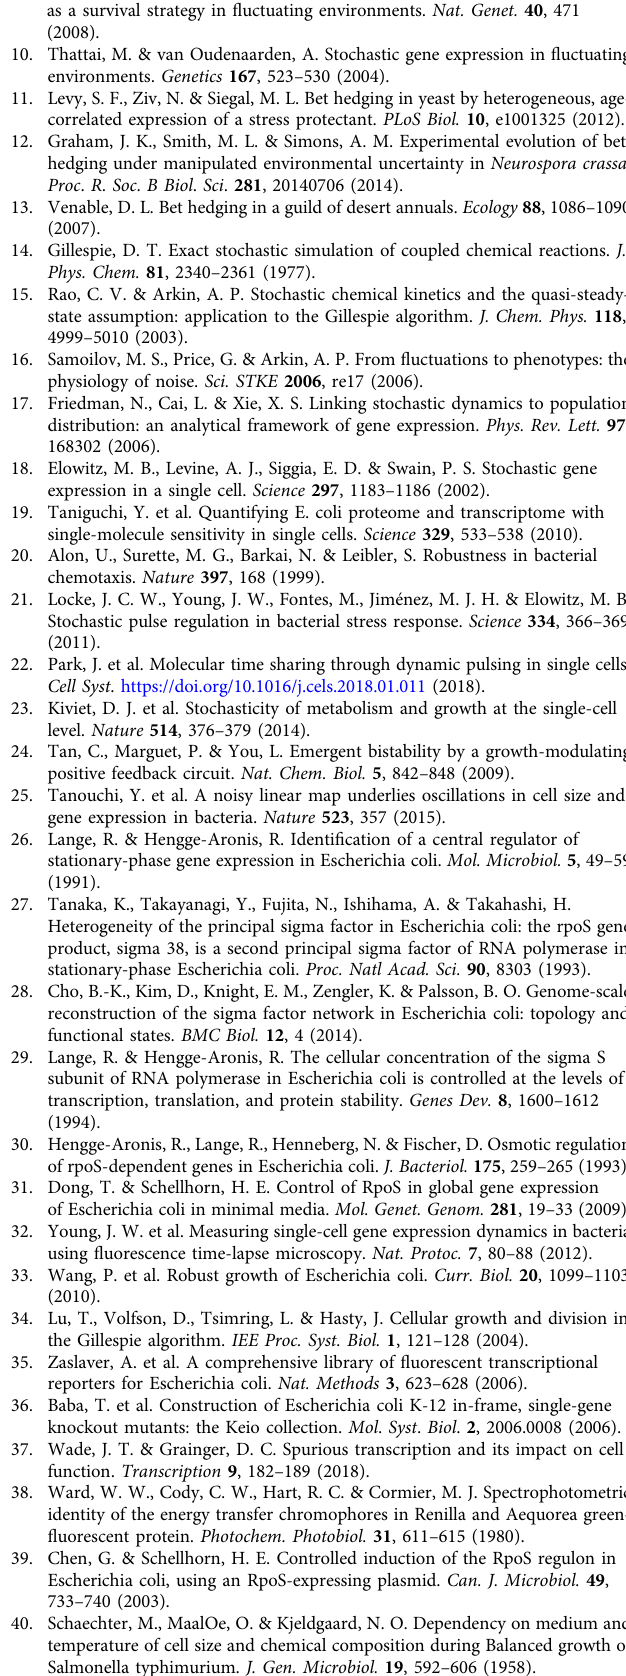
algorithm 14 that ran between the deterministic steps of the growth model. Two molecular species RpoS , r , and growth factor, γ , were modelled. They were gen- erated with zeroth order constitutive production and fi rst order degradation